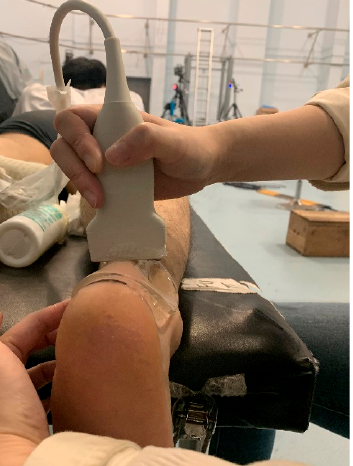
Figure 1. The measurement location of AT’s CSA.